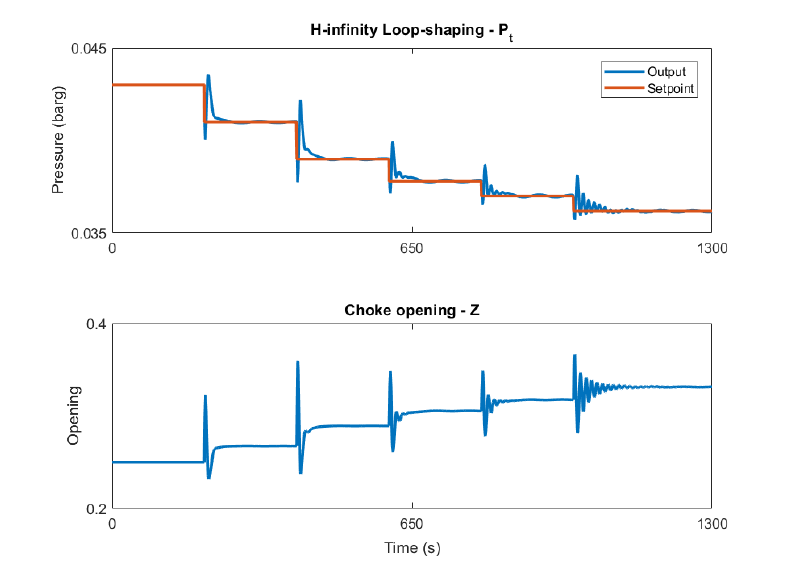
Figure 6. The non-linear model with the loop-shaping controller for P t . The setpoint is stepped to find highest allowed valve opening. At 1000 s the system stabilizes at highest allowed opening before reaching the closed-loop bifurcation point.